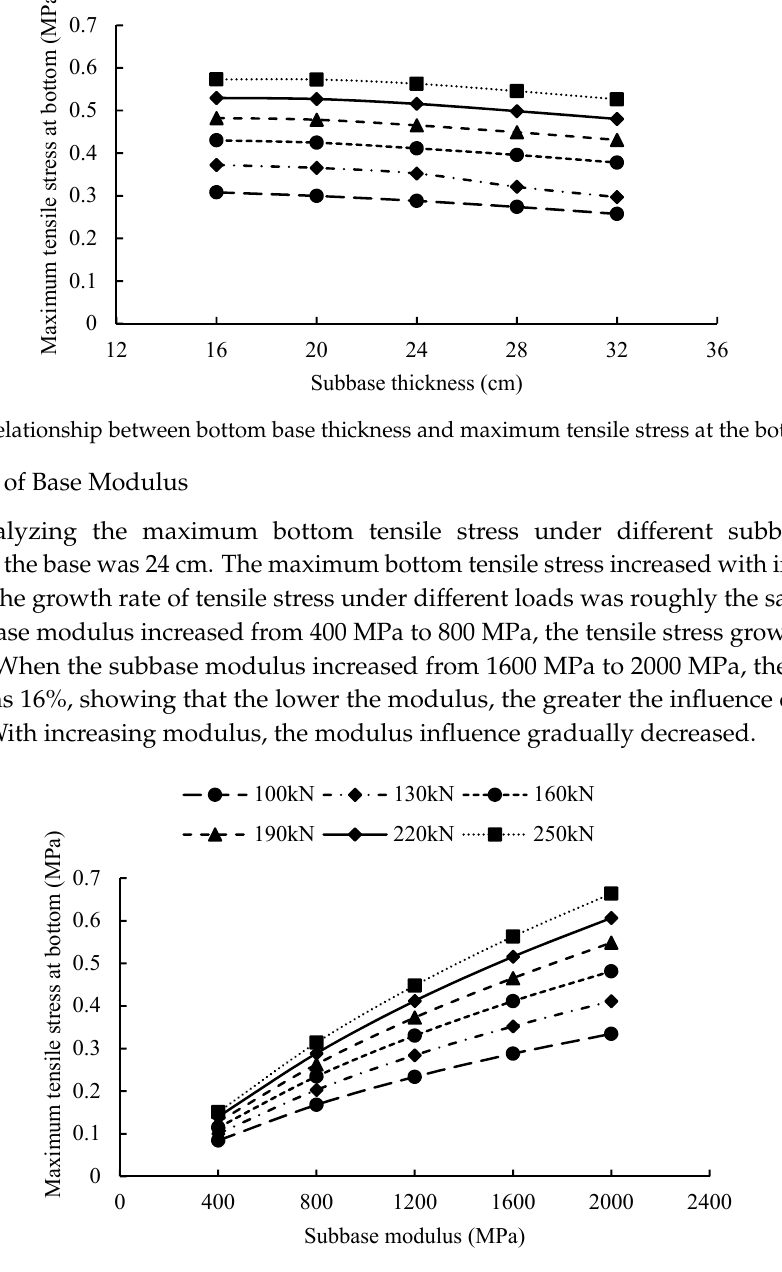
Figure 8. Relationship between bottom base modulus and maximum tensile stress at the bottom layer.